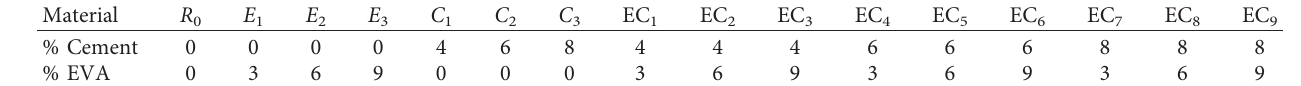
Table 6: Notations of the blended mixtures with various fractions of cement and